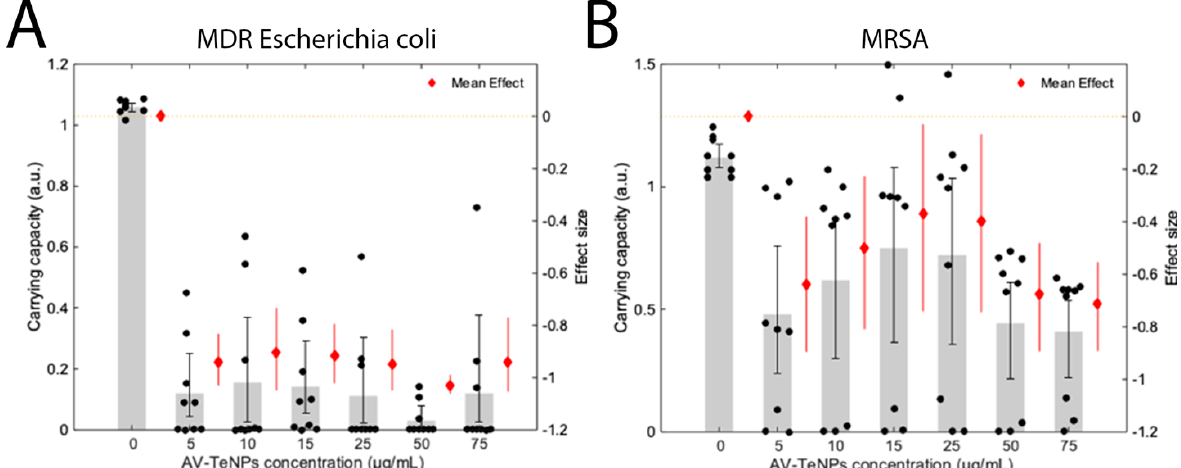
Figure A9. The carrying capacity and effect size against the shared control 0 concentration are shown in the above Cumming estimation plots for MDR Escherichia coli ( A ) and MRSA ( B ) experiments. Each mean difference is depicted as a diamond with a 95% confidence interval indicated by the ends of the vertical error bars. Three measurements were taken for each biological replicate (denoted as a black bold dot, ● ).